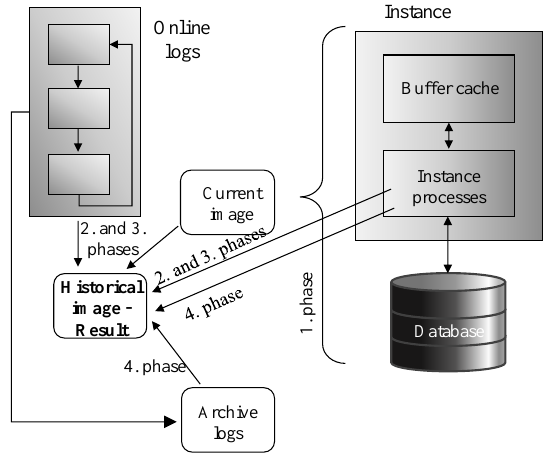
Figure 2. Historical data obtaining process—the current image starting point.